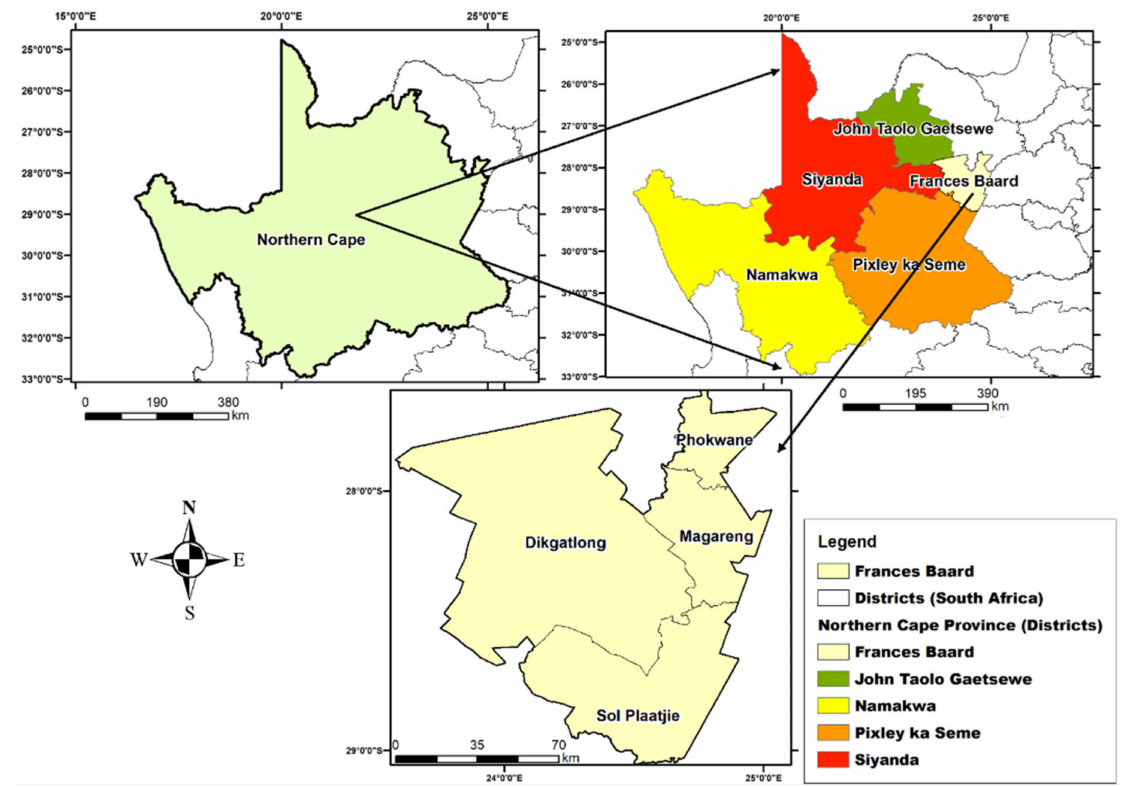
Figure 1. Map showing the Northern Cape Province and Frances Baard district municipality (FBDM). Source: Frances Baard district municipality